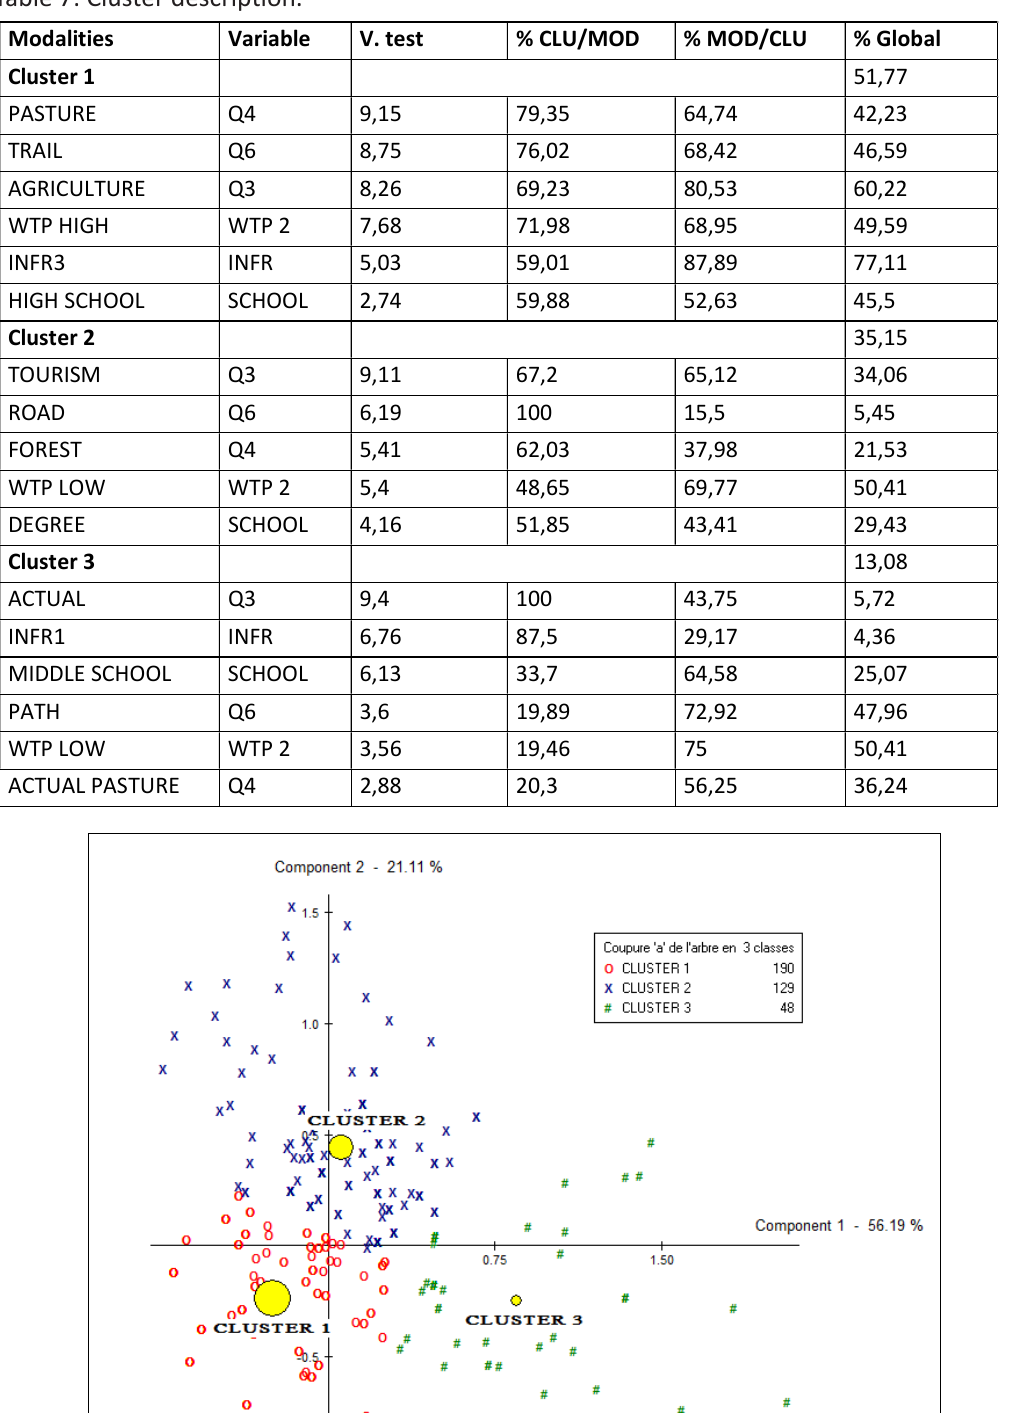
Table 7: Cluster description.